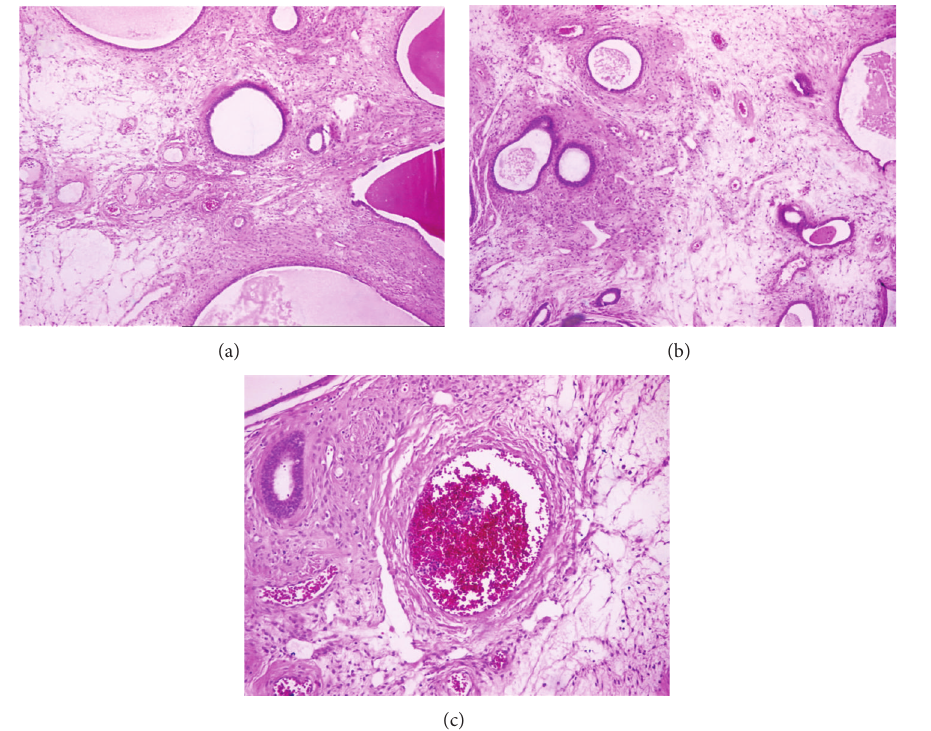
Figure 2: Microscopic examination of the polyp is composed of edematous and focal fibrotic stroma, large thick walled blood vessels between the endometrial glandular